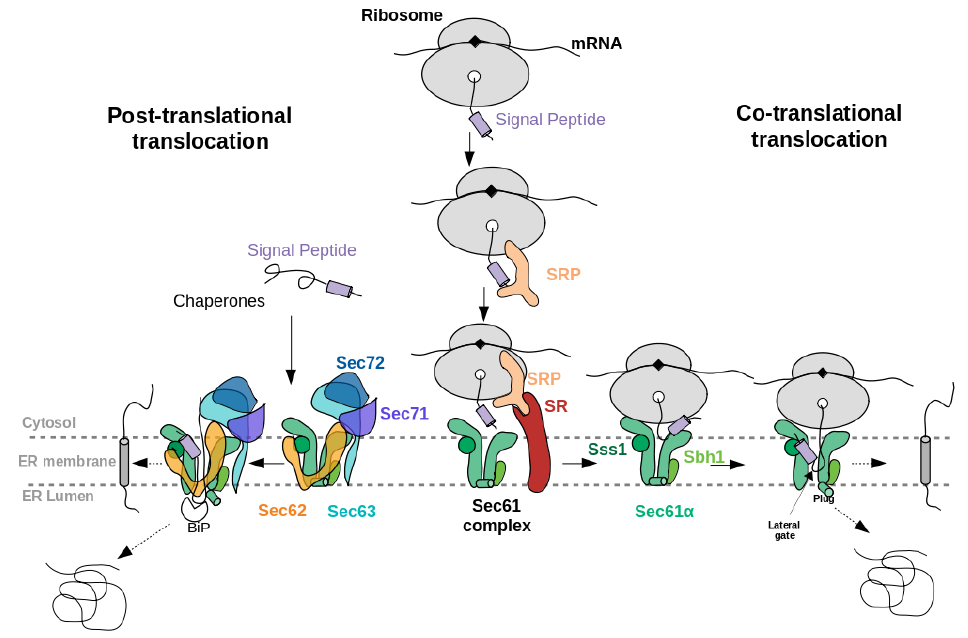
Figure 1. Schematic illustration of (left) the post-translational and (right) co-translational transloca- tion of a eukaryotic secretory protein through the Sec61 complex. In both co- and post-translational pathways, accessory proteins such as Sec62 and Sec63 help in the translocation of precursor proteins with “weak” signal peptides (see section “properties of signal peptides”). The accessory proteins Sec71 and Sec72 exist only in yeast. Sbh1 and Sss1 are the name of the β and γ sub-units of yeast Sec61